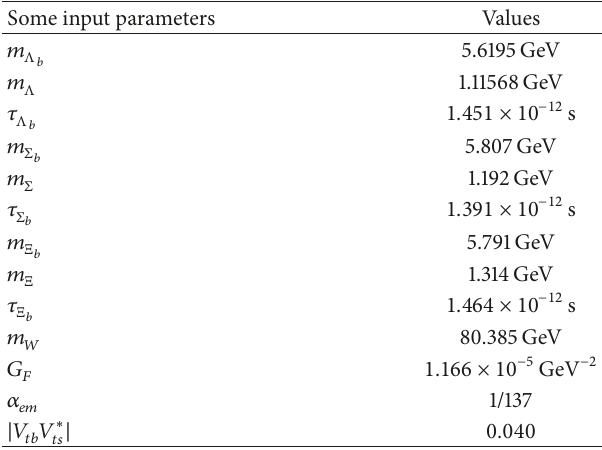
Table 1: The values of some input parameters used in our analysis [9].